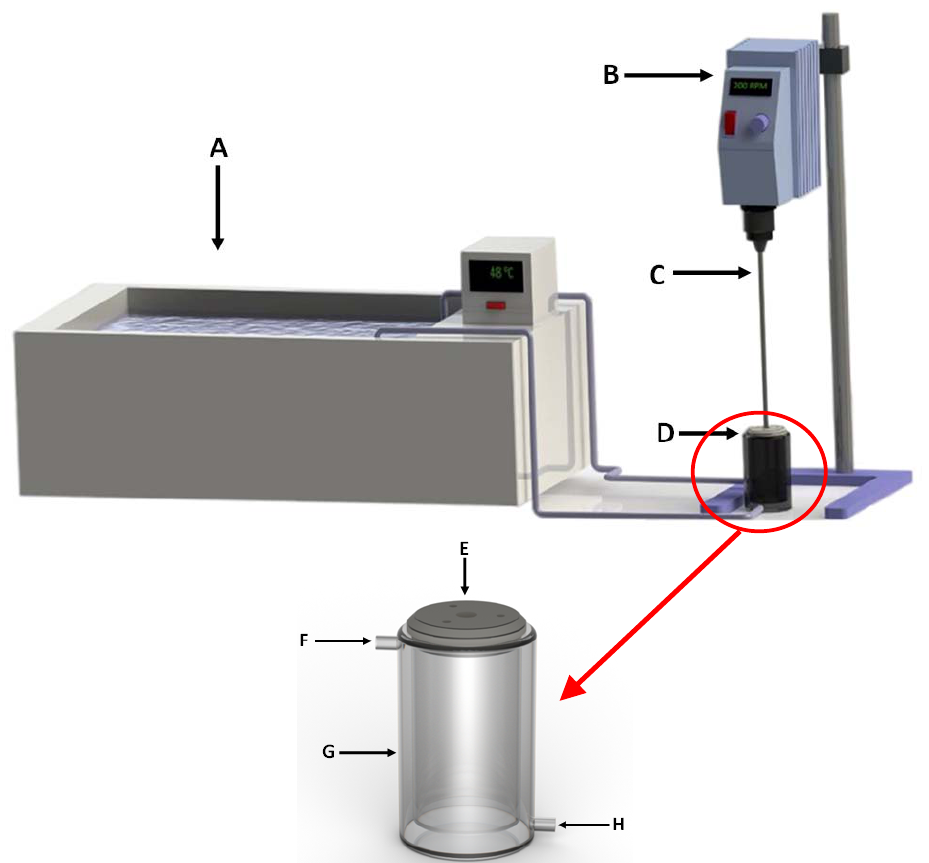
Figure 13. Experimental setup for aging step ( A ) Water bath; ( B ) Variable speed mixer; ( C ) 4-blade paddle impeller; ( D ) Double walled glass reactor; ( E ) Teflon reactor lid; ( F ) Heating water inlet; ( H ) Heating water outlet; ( G ) Double walled glass body.